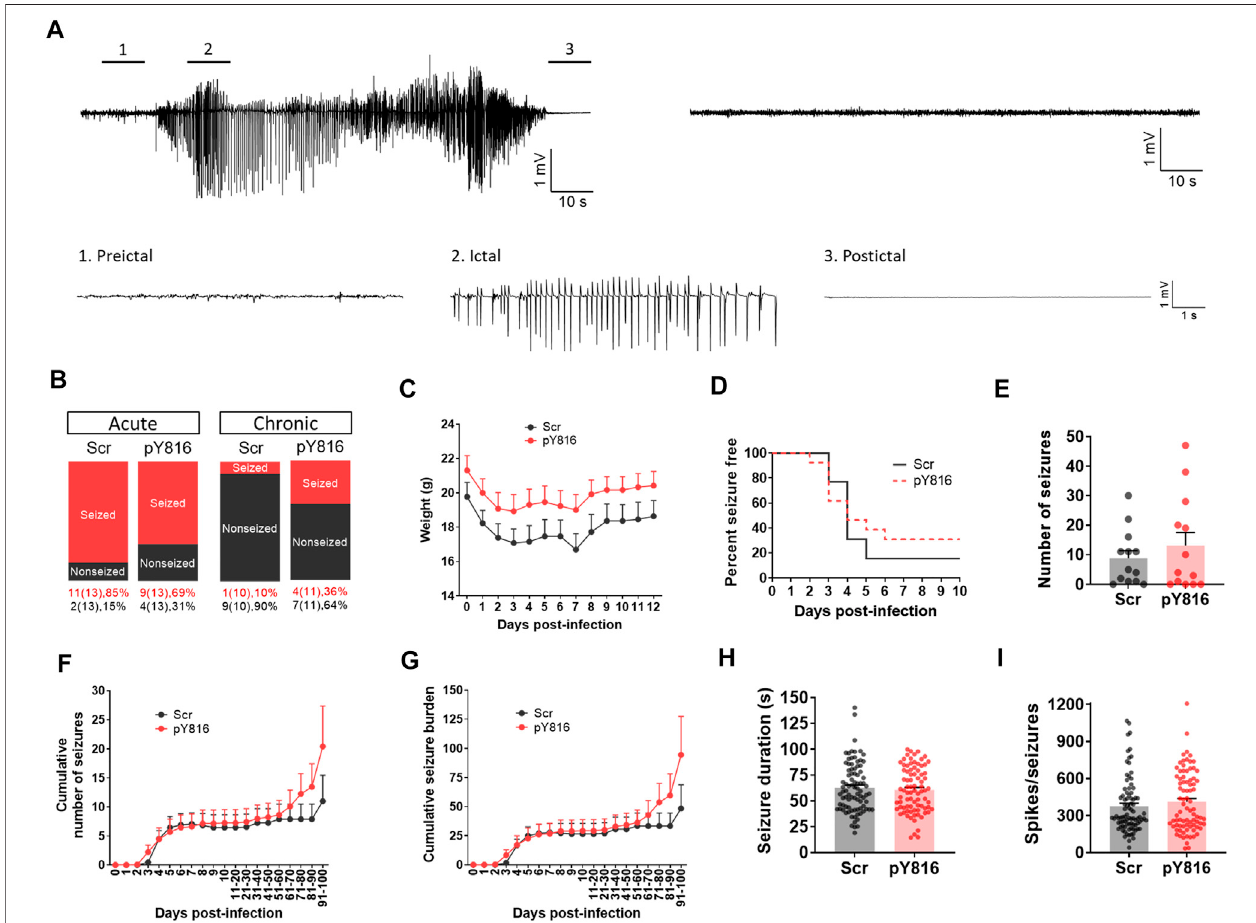
FIGURE 7 | No change in frequency, severity, and duration of TMEV-induced acute and chronic seizures between pY816- and sham-treated mice. (A) RepresentativeEEGrecordingsfromTMEV-infectedmicetreatedwithascrambledcontrolpeptide(Scr).Therecordingontheupperleftisfromamousethatdeveloped seizures and the recording on the upper right is from a mouse that did not have any seizure. Expanded traces corresponding to preictal baseline, ictal spiking, and postictal suppression period from a tracing on upper left are shown below. (B) Percentage of all TMEV-infected mice treated with either pY816 or a scrambled control peptide (Scr) that presented with acute and chronic seizures are shown. (C) Average weight of mice in each group during acute infection period. (D) This panel showsthepercentageoftotalinfectedmiceineachgroupthatremainedseizurefreeateachdayuntil10dpi.Noneofthemicedevelopedseizuresbefore2dpi. (E) Total number of seizures throughout the vECoG monitoring period post-TMEV infection is plotted for each mouse. (F) Average cumulative number of seizures for each treatmentgroupover100daysofvECoGmonitoringpost-TMEVinfection. (G) Averagecumulativeseizureburden,whichiscalculatedasameanofthesummationofall seizure scores for each mouse over time, compares seizure severity between Scr-treated and pY816-treated mice up to 100 dpi. (H) A graph plotting the duration of all seizures show no difference in mean seizure duration between both the treatment groups. (I) Total number of spikes plotted for each electrographic seizure shows no mean difference between both the treatment